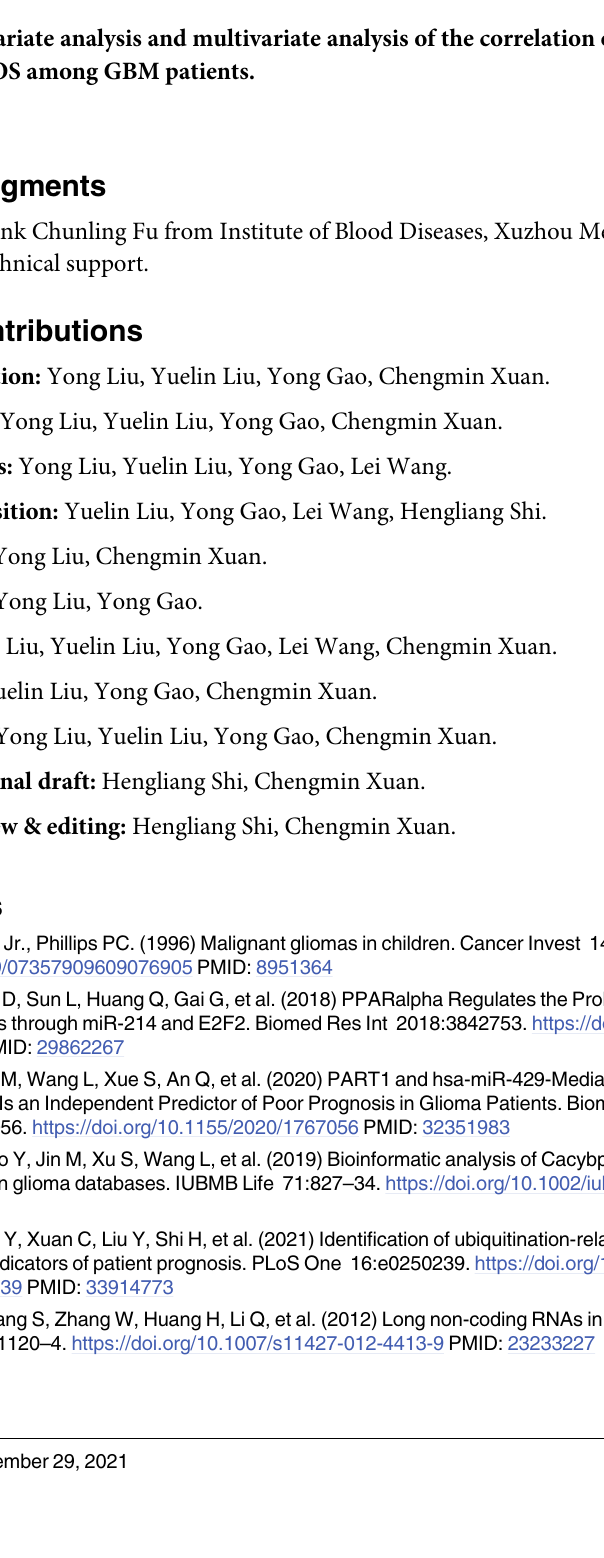
S1 Table. List of lncRNA, miRNA and mRNA in ceRNA. S2 Table. Univariate analysis and multivariate analysis of the correlation of the expression of NRP1 with OS among GBM